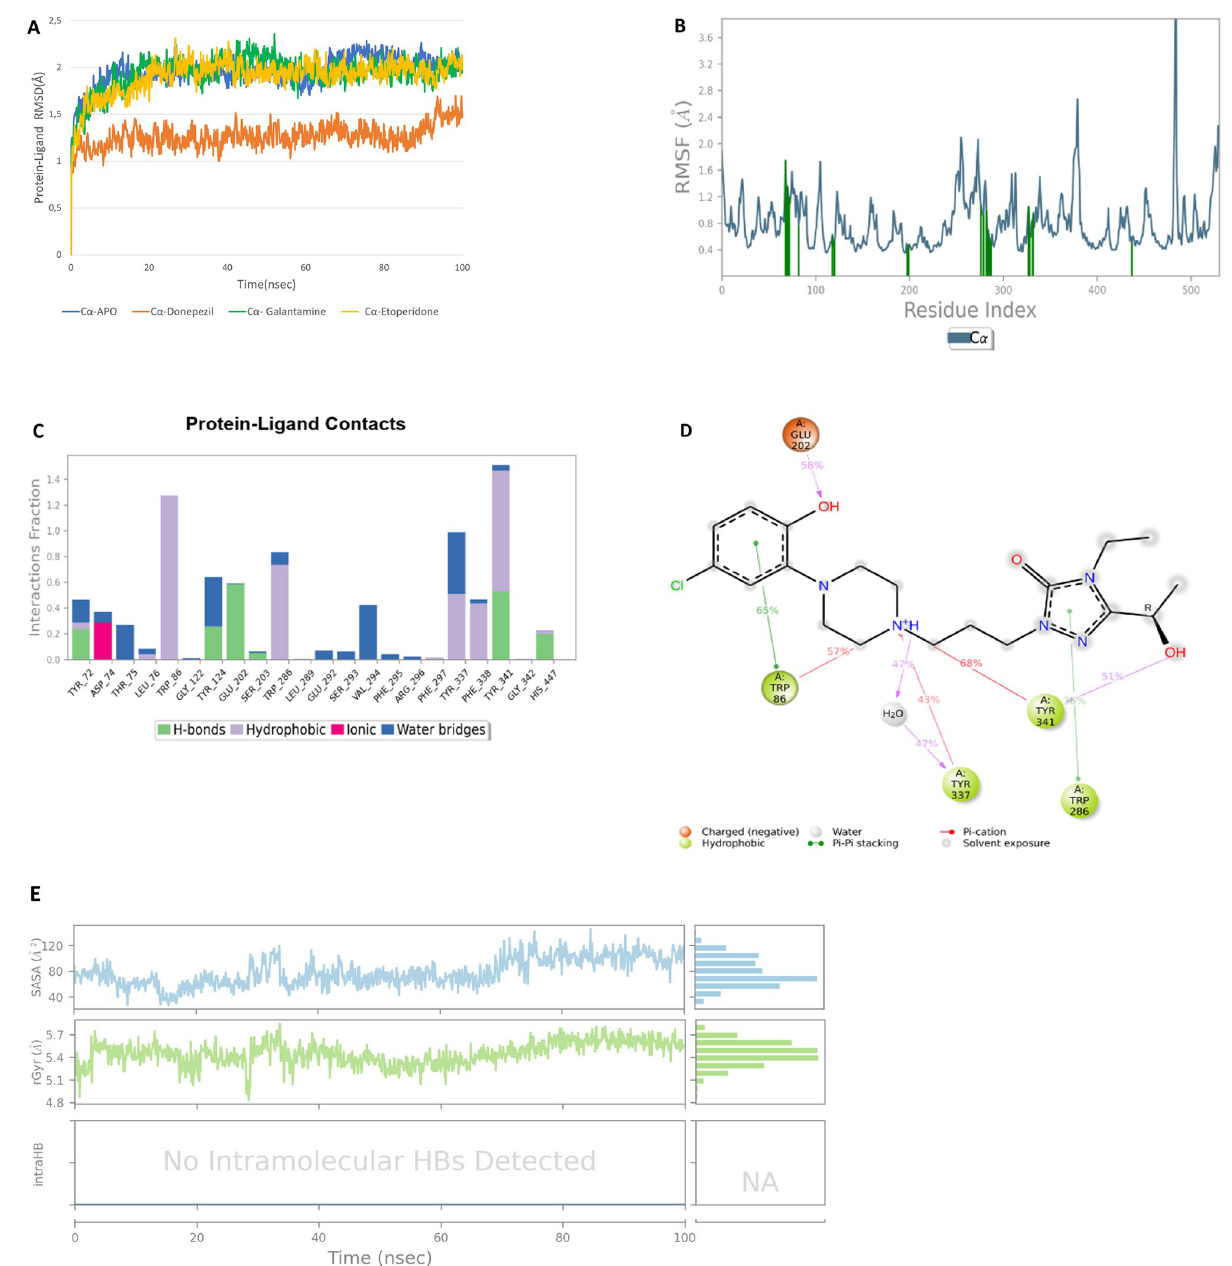
Fig 4. Molecular dynamics results of Etoperidone: RMSD (A), RMSF (B), protein-ligand fractions (C), protein-ligand contacts (% of simulation time) (D), SASA, radius of gyration and intramolecular hydrogen bonding (E) plots for Etoperidone.